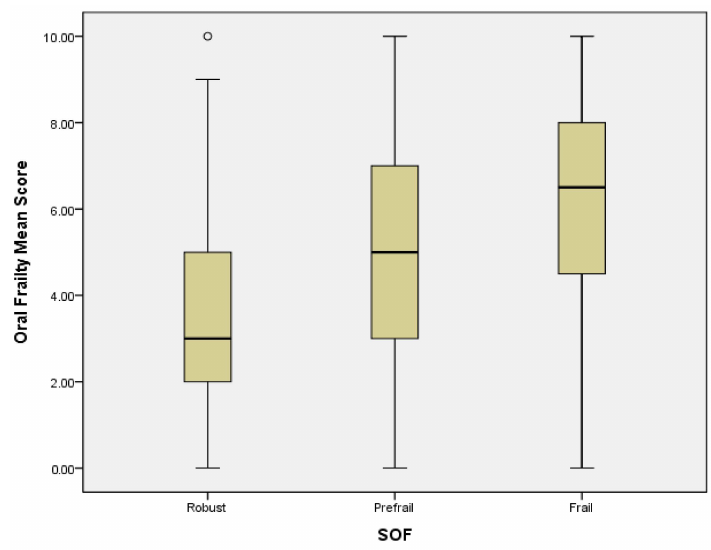
Figure 1. The correlation between OF mean score and PF. Mild outliers are marked with a circle “o”.